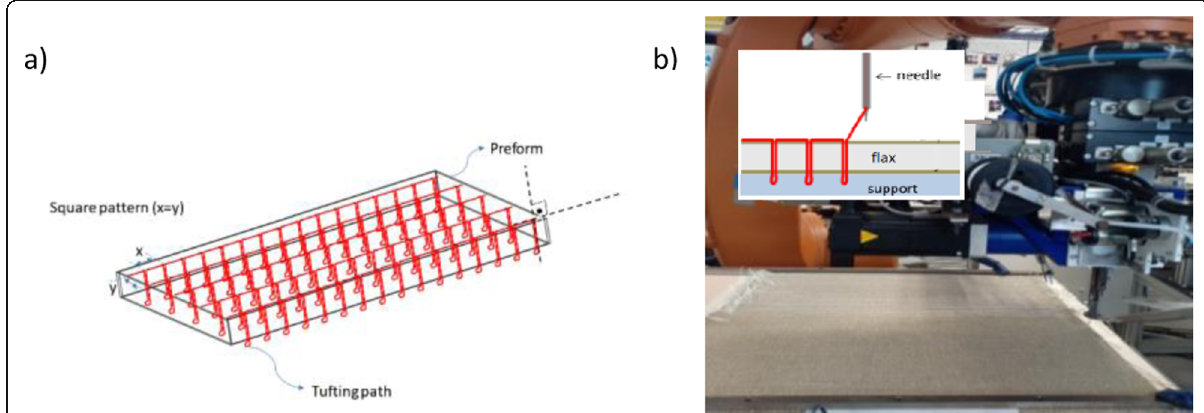
Fig. 1 a Schematic of transversal tufted specimens. b Tufting reinforcement in the Sheets of